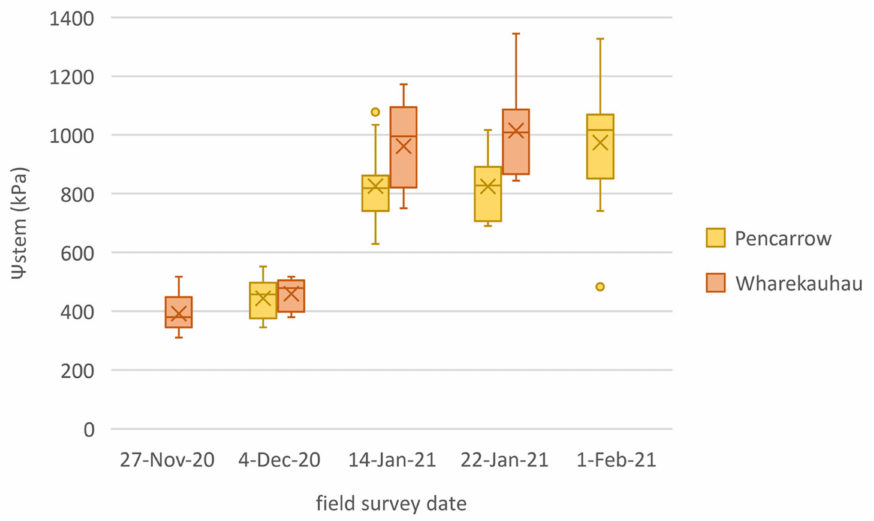
Figure 4. Boxplot of stem water potential ( Ψ stem) values for the full set of samples collected at Wharekauhau (n = 35) and Pencarrow (n = 50) vineyard. Table 6. Descriptive statistics of Ψ stem (kPa) of all the observations (n = 85).